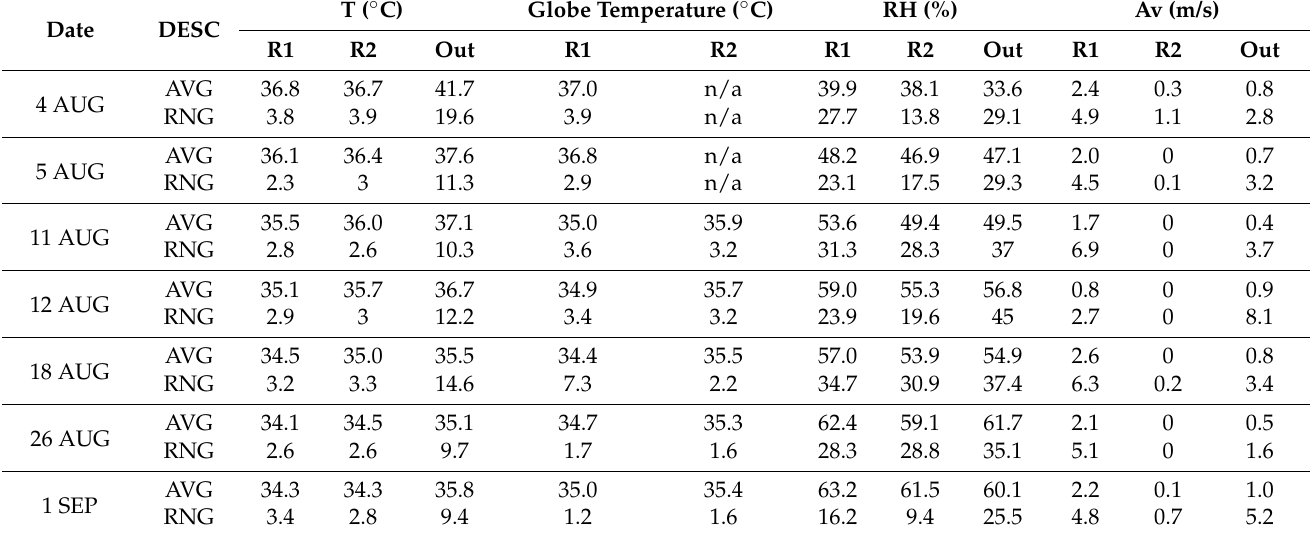
Table 9. Summary of thermal conditions during different days of the